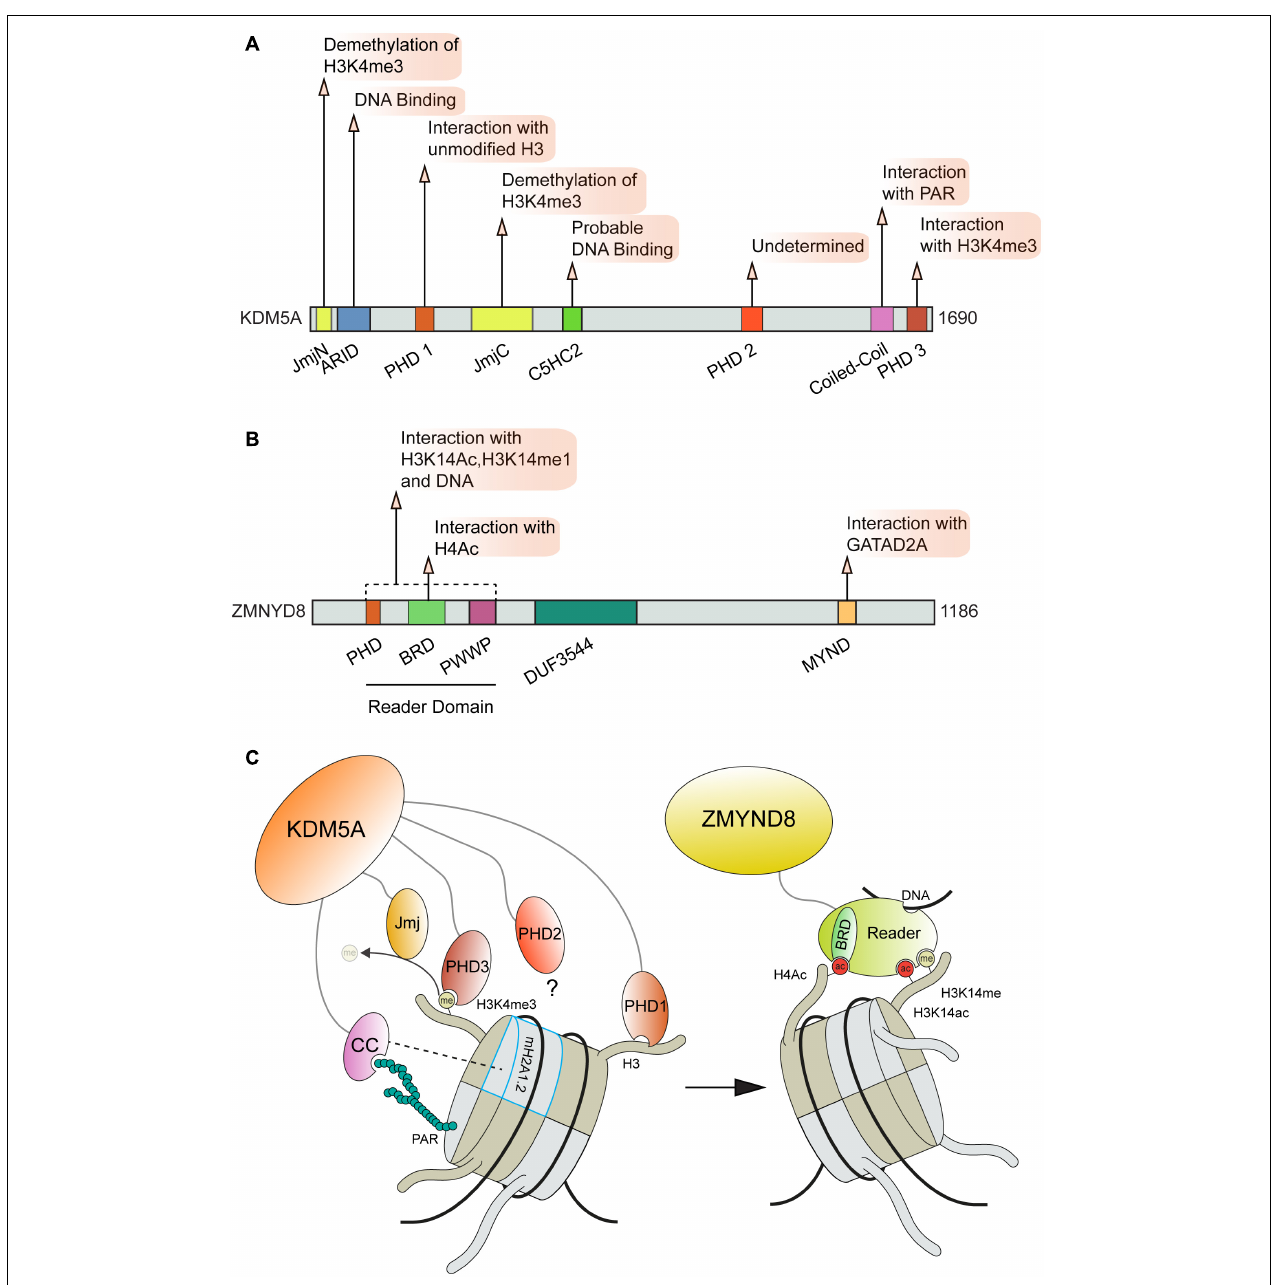
FIGURE 5 | Involvement of ZMYND8 and KDM5A domains and interactions in DNA repair. (A) KDM5A and (B) ZMYN8 protein domain maps and interactions. (C) KDM5A interactions that facilitate its function at breaks and recruitment of ZMYND8 to damage sites. KDM5A interacts with nucleosomes through recognition of unmodified H3 tails and H3K4me3 via its PHD1 and PHD3 domains, respectively. KDM5A also recognizes PAR chains and macroH2A1.2 through a coiled-coil (cc) domain. ZMYND8 binding to nucleosomes is facilitated primarily through its Reader domain which recognizes H4ac, H3K14me and H3K14ac histone marks. KDM5A, Lysine-specific Demethylase 5A; Jmj, Jumonji domain; ARID, A–T Rich Interaction Domain; PHD, Plant HomeoDomain; ZMYND8, Zinc Finger MYND-Type Containing 8; BRD, Bromodomain; PWWP, “Pro-Trp-Trp-Pro” domain; DUF, Domain of Unknown Function; MYND, Myeloid, Nervy, and DEAF-1 domain; CC, Coiled Coil; PAR, Poly